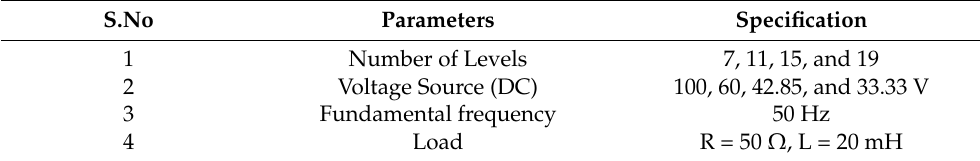
Table 2. Simulation